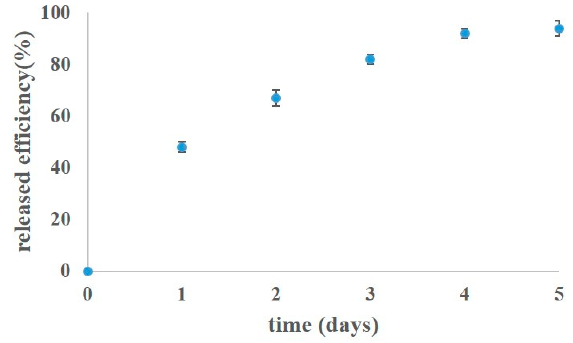
Figure 8. Drug release profile for tetracycline-loaded CHTP composite material. Error bars represent standard deviations of triplicate measurements.